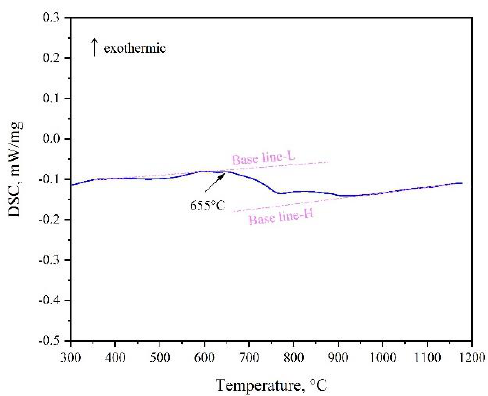
Figure 9. DSC curve of alloy A1 with a heating rate of 10°C/min.